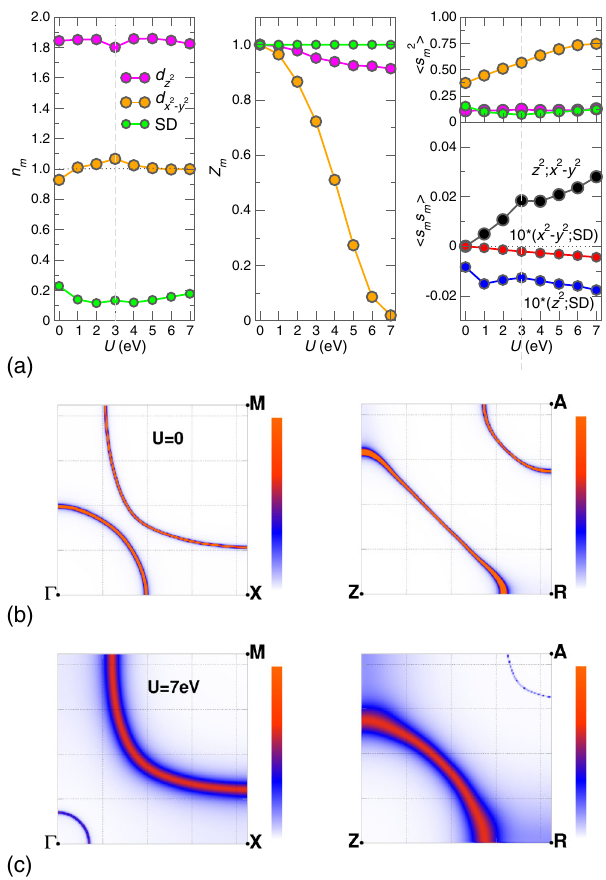
FIG. 7. Minimal-Hamiltonian properties at half-filling for μ 12 U= 2 . (a) Selected quantities for increasing U . The Hund ’ s SD ¼ U= 3 for U < 3 and fixed to J exchange is chosen as J H ¼ H ¼ 1 eV for U ≥ 3 eV (the dashed gray line separates the regimes). From left to right: Orbital occupation n , orbital-resolved QP m weight, and local squared-spin moment (top), as well as local spin-spin correlation (bottom). (b) Noninteracting Fermi surface 0 (left) and k 1 = 2 (right). (c) Interacting Fermi for k z ¼ z ¼ surface for U ¼ 7